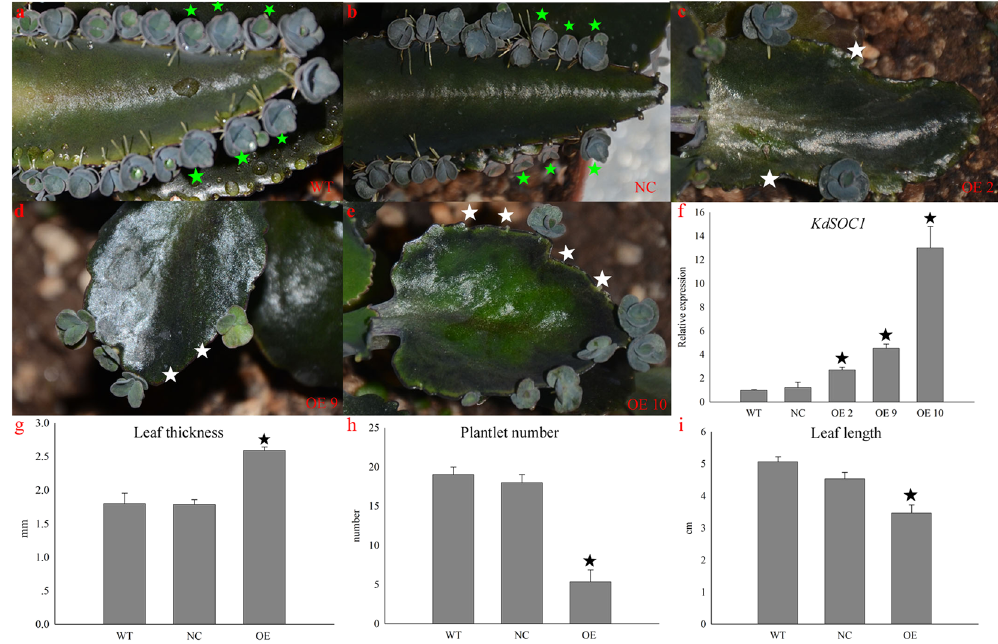
Figure 4. Asymmetric distribution of plantlets along leaf margin in KdSOC1 OE lines. ( a ) Normal symmetrical plantlets distribute along WT plant leaf margin. ( b ) Normal symmetrical plantlets distribute along NC plant leaf margin. ( c–e ) Asymmetric distribution of plantlets along OE line 2, 9, 10 plant leaf margin. ( f ) KdSOC1 gene expression in WT, NC and OE plant leaves. ( g–i ) Leaf thickness, plantlet number and leaf length in WT, NC and OE plants. White pentagram indicates the loss of pedestal site for plantlet formation and green pentagram indicates the symmetric plantlet. Dark pentagram indicated significantly different from the WT ( P < 0.05). Errors bars represent ± SD (standard deviations) of three independent